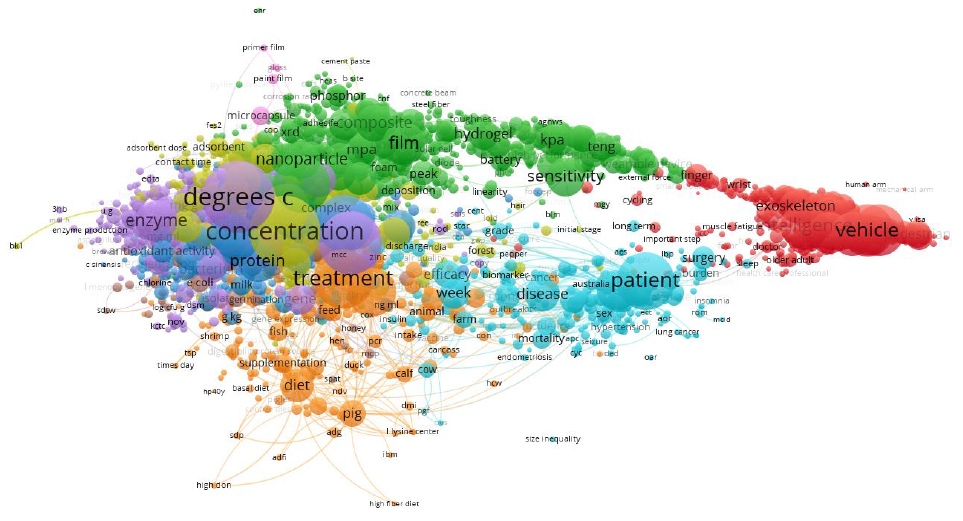
Figure 7. Term co-occurrence map based on provided publications Web of Science.